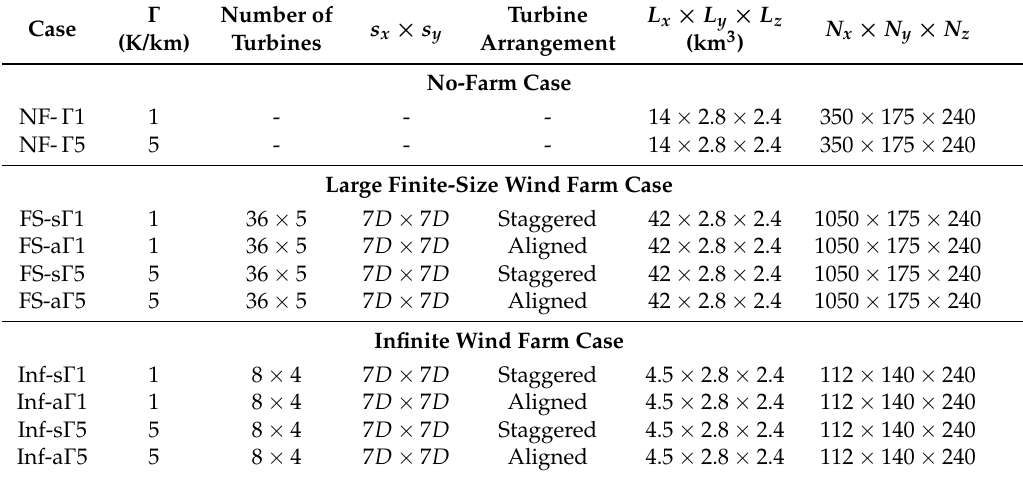
Table 1. Suite of LES